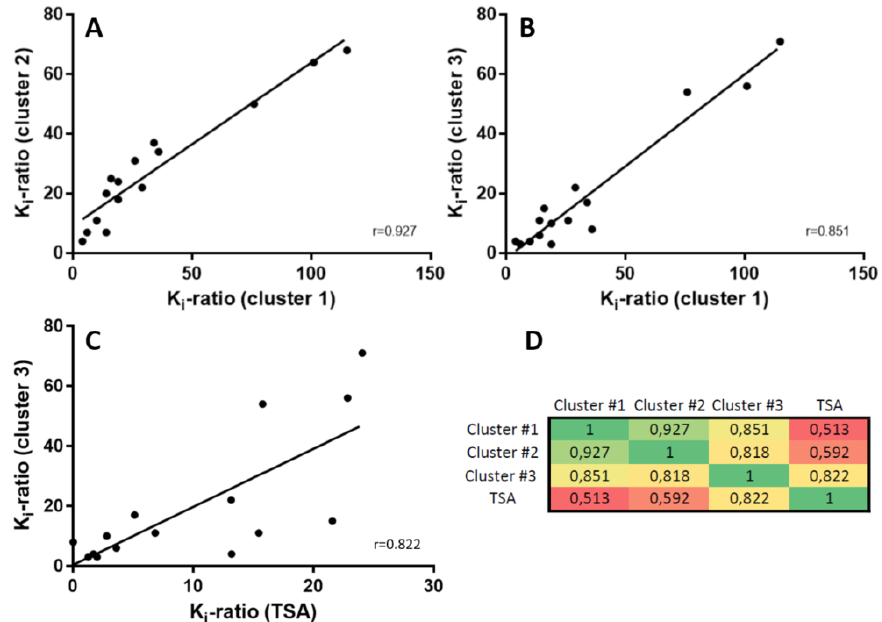
Figure 7. Binding profiles of TZD ligand clusters and TSA to HDAC4. Each data point represents a HDAC4-mutant, where one of the amino acids K664, E677, S758, D759, N763, E764, R798, T808, M810, F812, C813, R864, F871 or L943 is exchanged against alanine. The ratio of K i -values for binding to a mutant variant and cdHDAC4 wt indicates the impact of this specific mutation on the molecular recognition of a particular ligand. ( A ) Averaged K i -ratios for binding of TZD ligand cluster 2 and ( B ) TZD ligand cluster 3 are plotted versus the averaged K i -ratios of TZD ligand cluster 1. ( C ) The averaged K i -ratios of TZD ligand cluster 3 is plotted versus the K i -ratio of reference compound TSA. ( D ) Heat map of Spearman correlation coefficients for K i -ratios of indicated clusters and TSA.